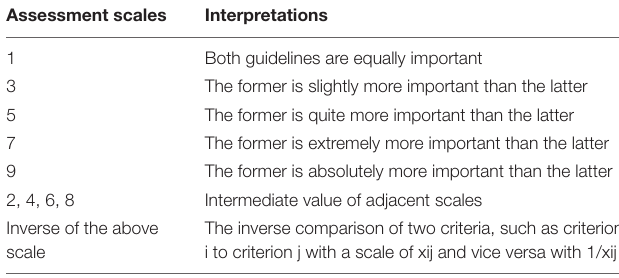
TABLE 1 | Assessment scales and their interpretations.